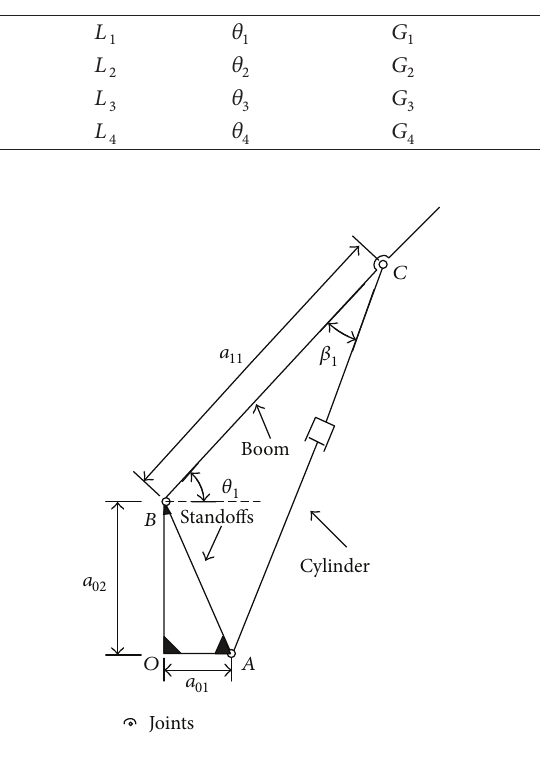
Figure 2: Connection relationship between the first boom and the hydraulic